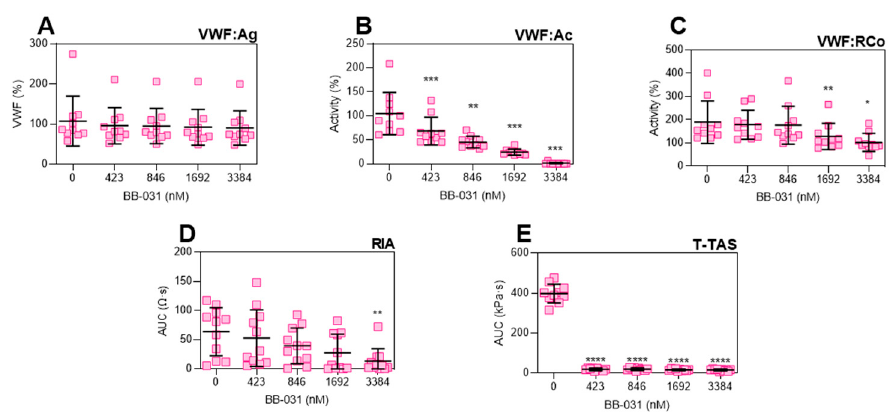
Figure 1. VWF function panel. Dose–response of ( A ) VWF:Ag, ( B ) VWF:Ac, ( C ) VWF:RCo, ( D ) Ristocetin-induced whole blood impedance aggregometry (RIA), and ( E ) T-TAS. N = 10. Individual data points are shown. Error bars represent mean ± standard deviation (SD). **** p < 0.0001; *** p < 0.001; ** p < 0.01, * p < 0.05.